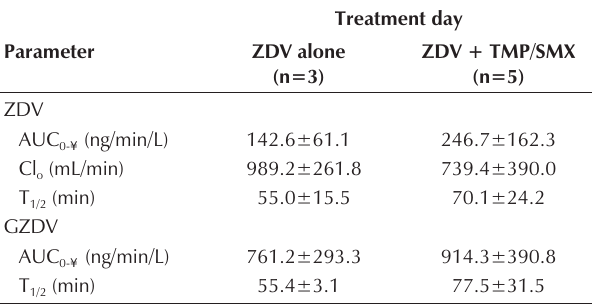
Mean pharmacokinetic parameters of zidovudine (ZDV) and zidovudine glucuronide (GZDV) in the presence and absence of trimethoprim/sulphamethoxazole